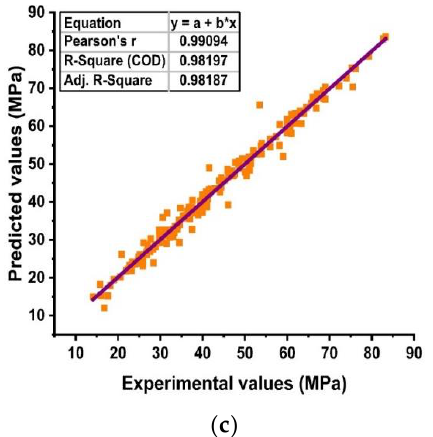
Figure 5. ANN ( a ) training, ( b ) validation, ( c ) testing.